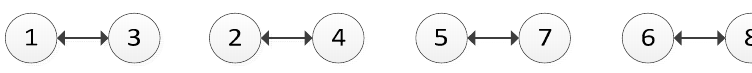
Figure 2. Graph Model of Changzhou Conflict for Movement by EPA.